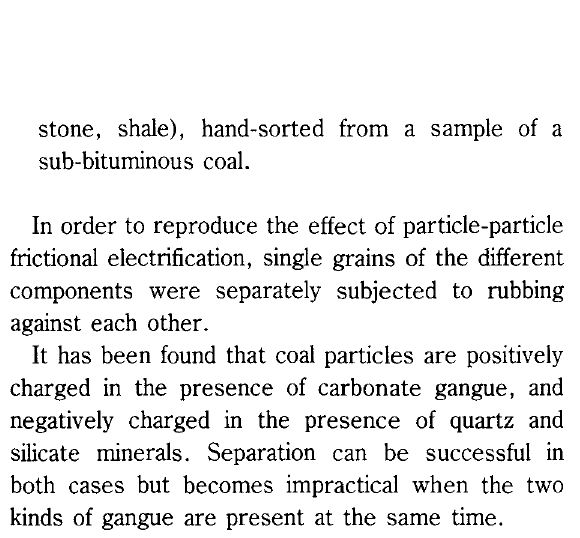
Results of triboelectric separation for an Algerian phos phate ore. 1-Recovery; 2- Concentrate grade; 3- Loss in the reject - pyrite, calcite and shale also take a positive